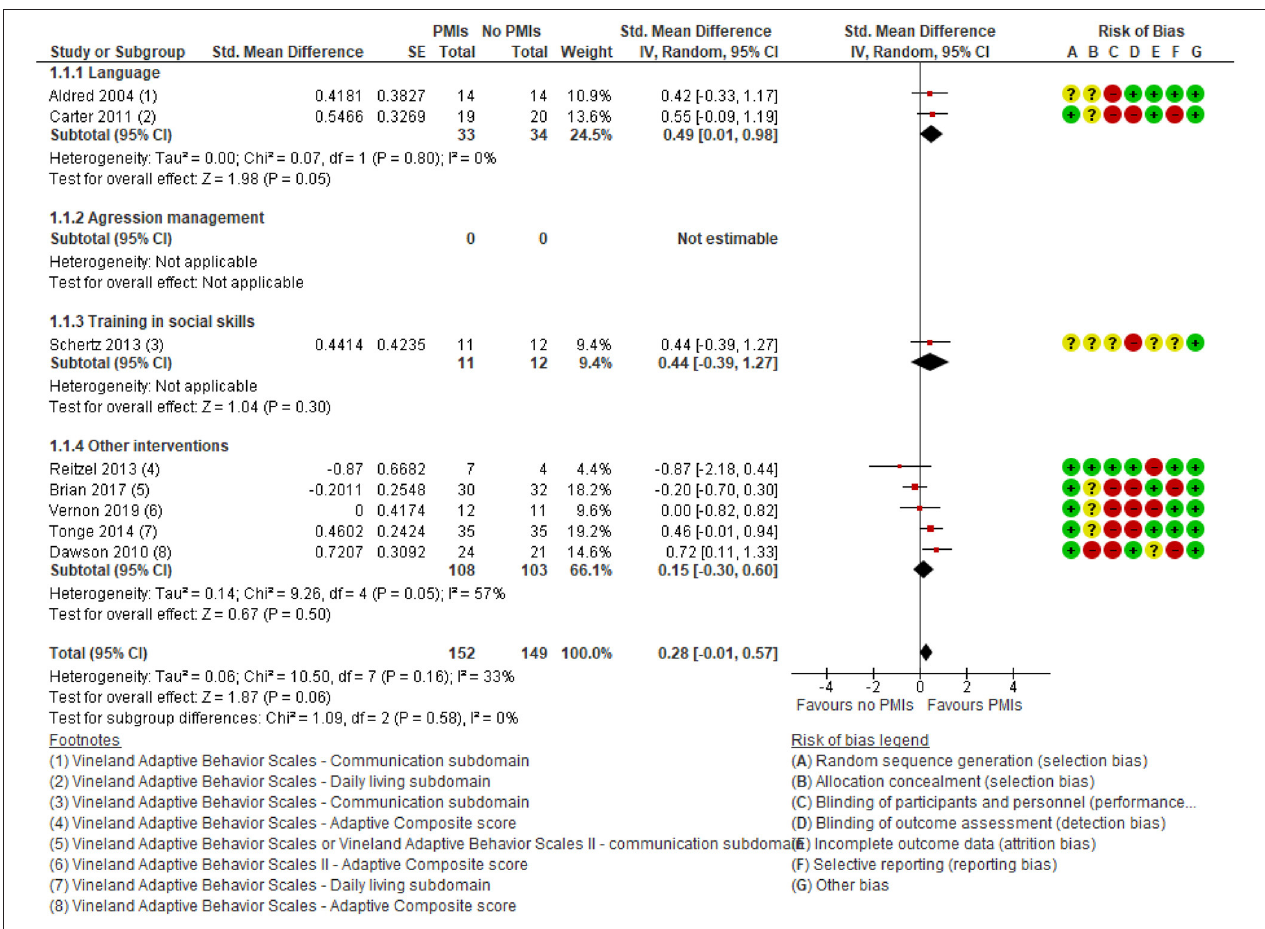
FIGURE 4 | Forest plot of comparison: PMI vs. no PMI, outcome: adaptive functioning, parent-rated, lower is